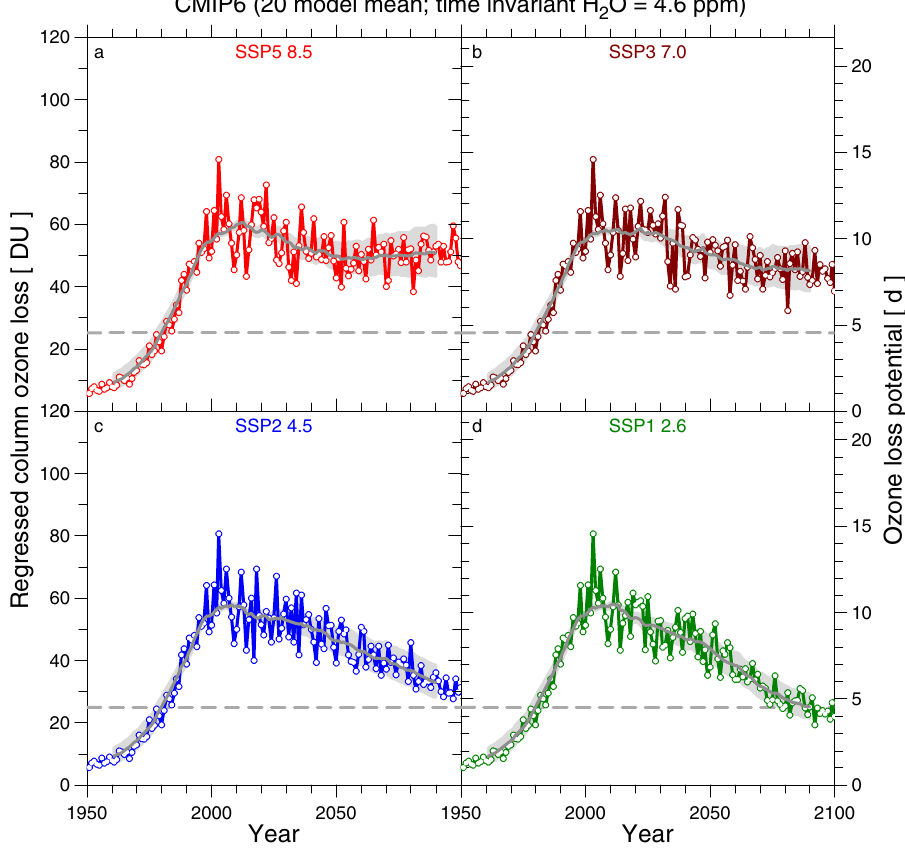
Fig. 8 Ensemble model mean regressed column ozone loss and Ozone Loss Potential (OLP), time-invariant H 2 O. The value of OLP (right ordinate) and Δ O REG computed from OLP (left ordinate) from the 20 CMIP6 GCMs (CanESM5, CESM2-WACCM, CNRM-CM6-1, CNRM-CM6-1-HR, CNRM-ESM2-1, 3 EC-Earth3, EC-Earth3-Veg, FGOALS-g3, IITM-ESM, INM-CM4-8, INM-CM5-0, IPSL-CM6A-LR, MIROC6, MIROC-ES2L, MPI-ESM1-2-HR, MPI-ESM1-2-LR, MRI-ESM2-0, NorESM2-LM, NorESM2-MM, UKESM1-0-LL) that archived results for the SSP5-8.5 ( a ), SSP3-7.0 ( b ), SSP2-4.5 ( c ), and SSP1-2.6 ( d ) scenarios, computed assuming a constant volume mixing ratio for stratospheric H 2 O of 4.6 ppmv. The same temperature threshold offsets speci fi ed in Table 1 and Figs. 4 and 5 have been used. The grey solid line shows a 21-year running mean (±10 years) to the ensemble mean of Δ O 3 REG for each SSP, the grey shaded area represents a 21-year running mean of the range in Δ O 3 REG for exponents of 1 (upper boundary) and 1.4 (lower boundary) of the expression for OLP, and the grey dashed horizontal lines denoted the 1980 value of Δ O 3 REG . The right-hand ordinate shows the scale of the multi-model mean values of OLP, which are the initial quantities computed from the GCM output. Note, this right-hand ordinate does not correspond to the grey shaded area, since an exponent different from 1.2 was